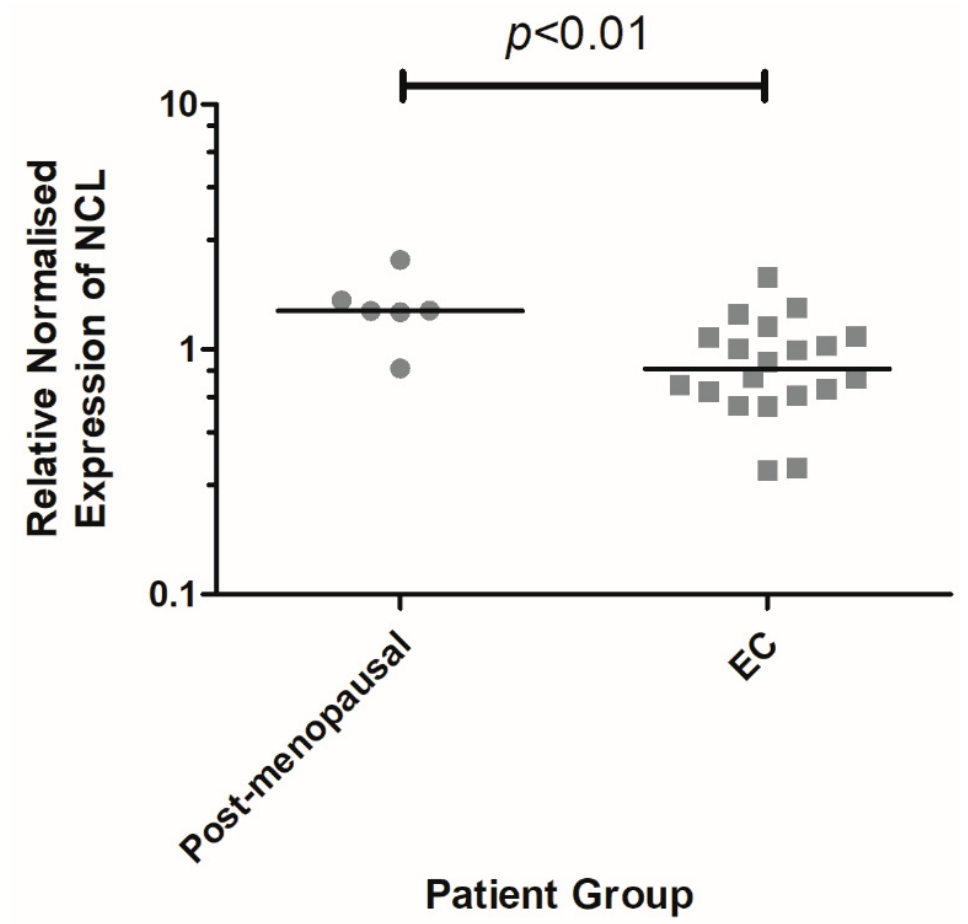
Figure 1. Scatter plot of NCL mRNA expression using RT-qPCR in post-menopausal ( n = 6) versus endometrial cancer tissue ( n = 20; G1 endometrioid n = 3, G2 endometrioid n = 3, G3 endometrioid n = 6, serous n = 2, carcinosarcoma n = 3, clear cell n = 3); line indicates the median.